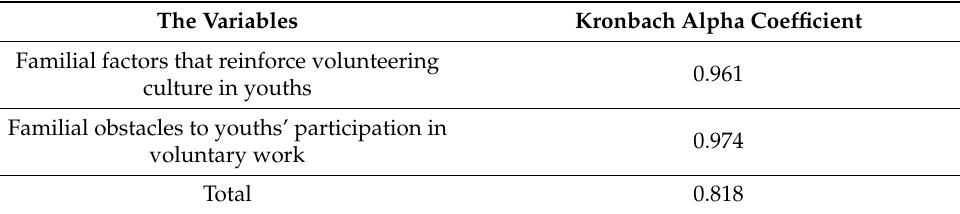
Table 2. Reliability coefficients of the research tool’s items calculated using Cronbach’s